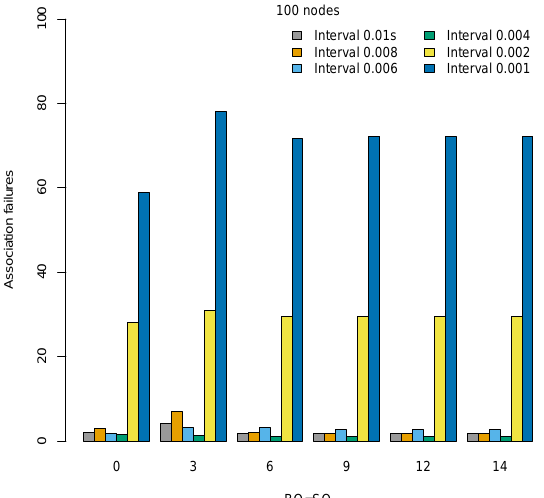
Figure 15. Association request failures (channel access failure, lost ACK, lost response).